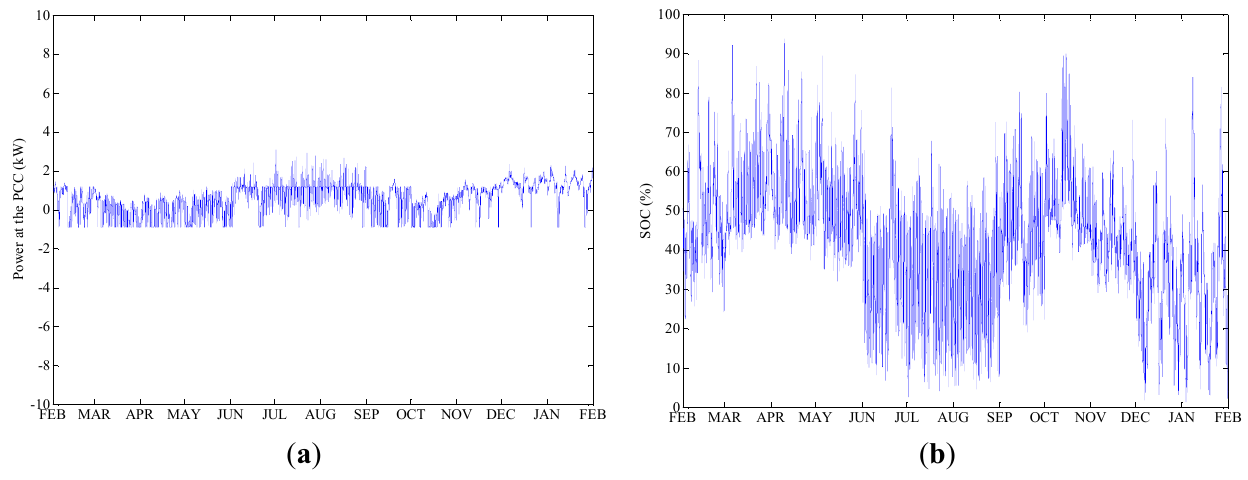
Figure 15. ( a ) Power exchanged with the grid; and ( b ) useful SOC during a